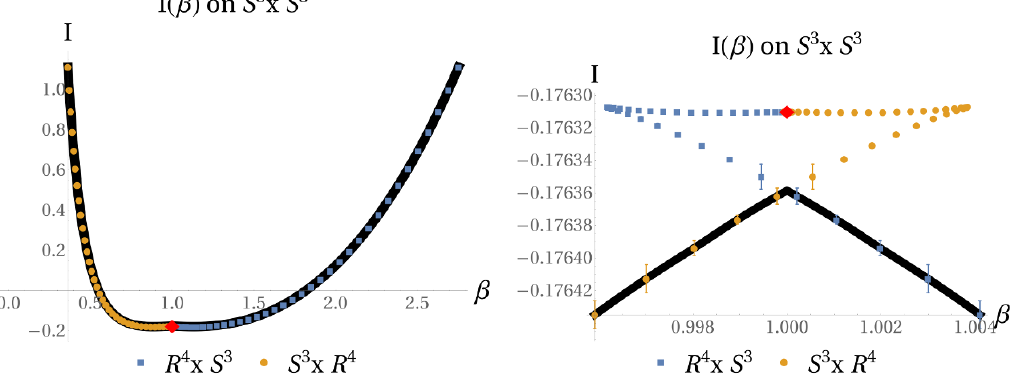
Figure 9 . The action I as a function of the ratio of radii (cid:12) for both topologies with conformal boundary S 3 (cid:2) S 3 . The red diamond is the analytical calculation for the singular ratio (cid:12) s = 1, and the black line follows the dominant solution for each ratio (cid:12) . We see that there is a (cid:12)rst order phase transition at (cid:12) c = 1.